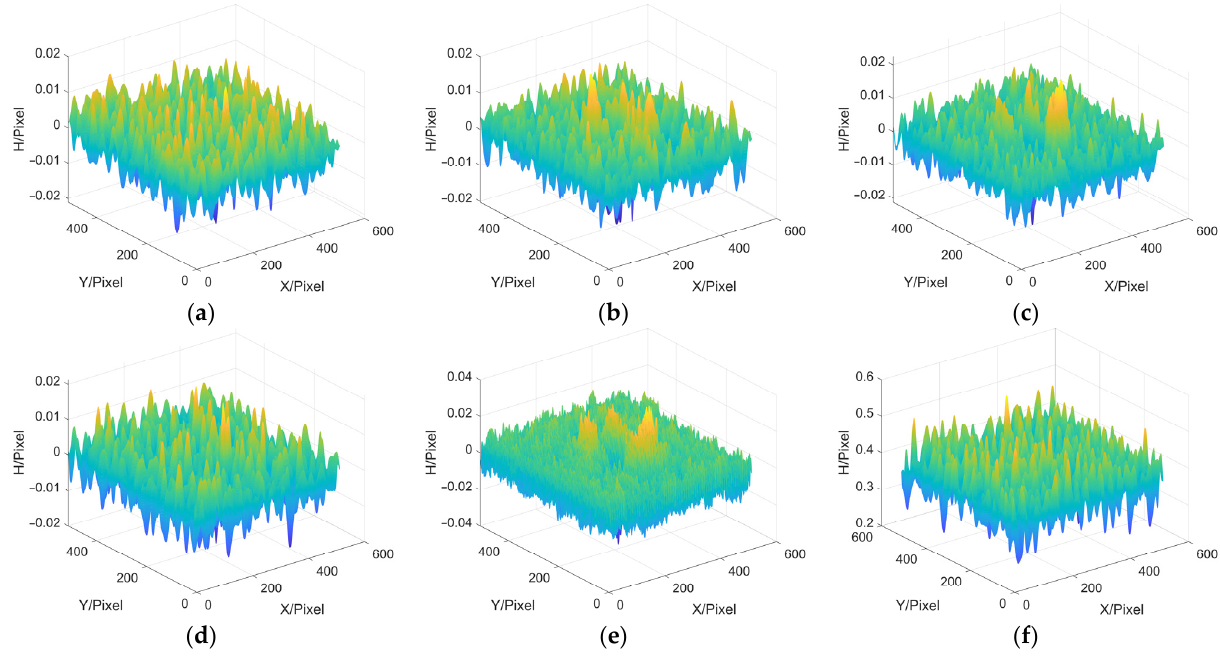
Figure 8. Reconstruction errors (With noise). ( a ) MP based on Ideal low-pass; ( b ) MP based on Hanning; ( c ) MP based on Blackman; ( d ) MP based on Kaiser; ( e ) MP based on Hilbert transform; ( f ) FTP.